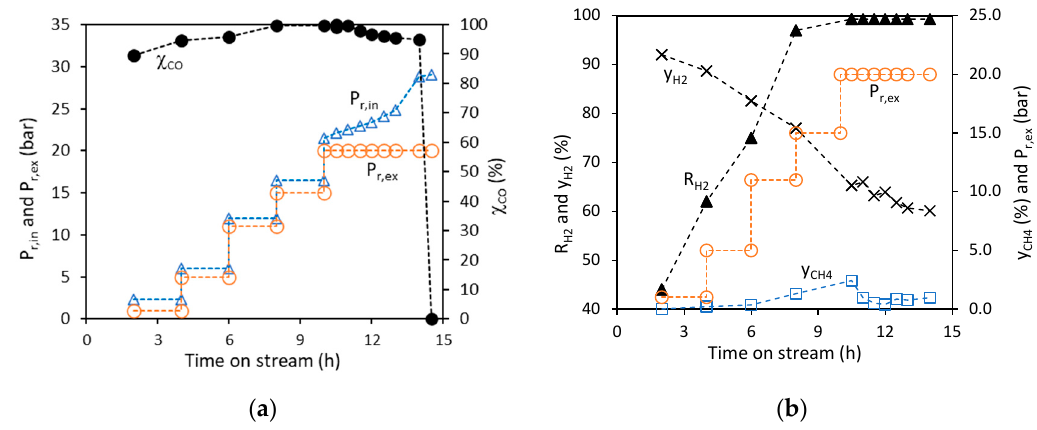
Figure 1. Results of WGS reaction at 500 °C in the zeolite MR as a function of time ‐ on ‐ stream with correspondingly increasing reaction pressure and constant atmospheric pressure on the permeate side: ( a ) χ CO and corresponding 𝑃 (cid:3045),(cid:3036)(cid:3041) and 𝑃 (cid:3045),(cid:3032)(cid:3051) , and ( b ) R H2 and y H2 in permeate and y CH4 in retentate.